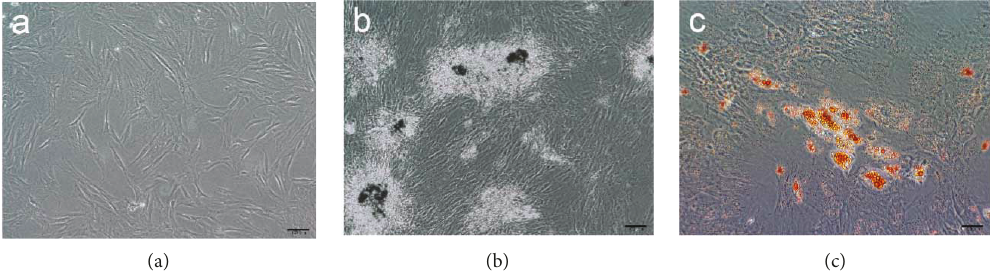
Figure 1: Di ff erentiation of hASCs. (a) hASCs (p3) were observed under an inverted microscope while suspended in normal complete medium and were found to be spindle-shaped. (b) After incubating in osteogenesis medium for 3 weeks, the cells were subjected to von Kossa staining, which demonstrated the presence of calcium deposits (black). (c) Oil Red O staining con fi rmed that lipid droplets (orange) had formed after the cells were incubated in adipogenic di ff erentiation medium for 2 weeks. Scale bar =100 μ m. hASCs: human adipose- derived stem